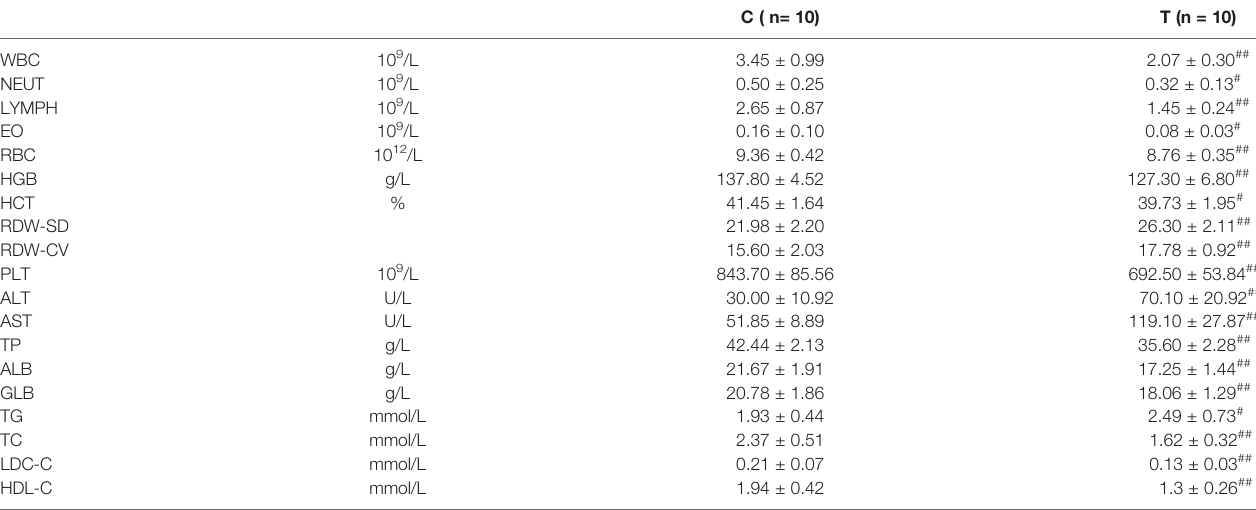
TABLE 1 | Changes in differential blood count and biochemical index in mice with thyrotoxicosis.